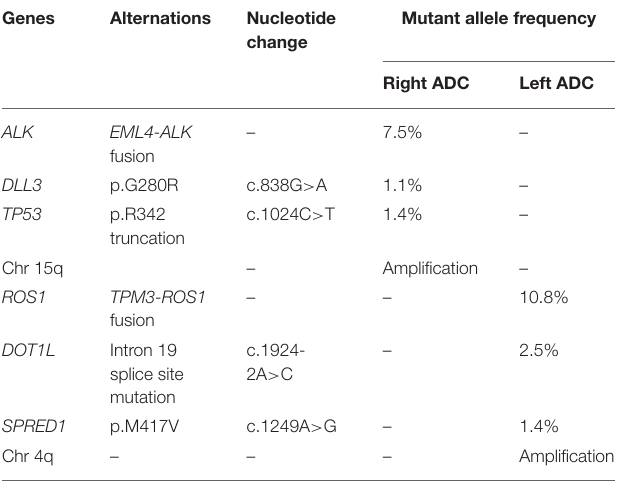
Frontiers in Oncology |